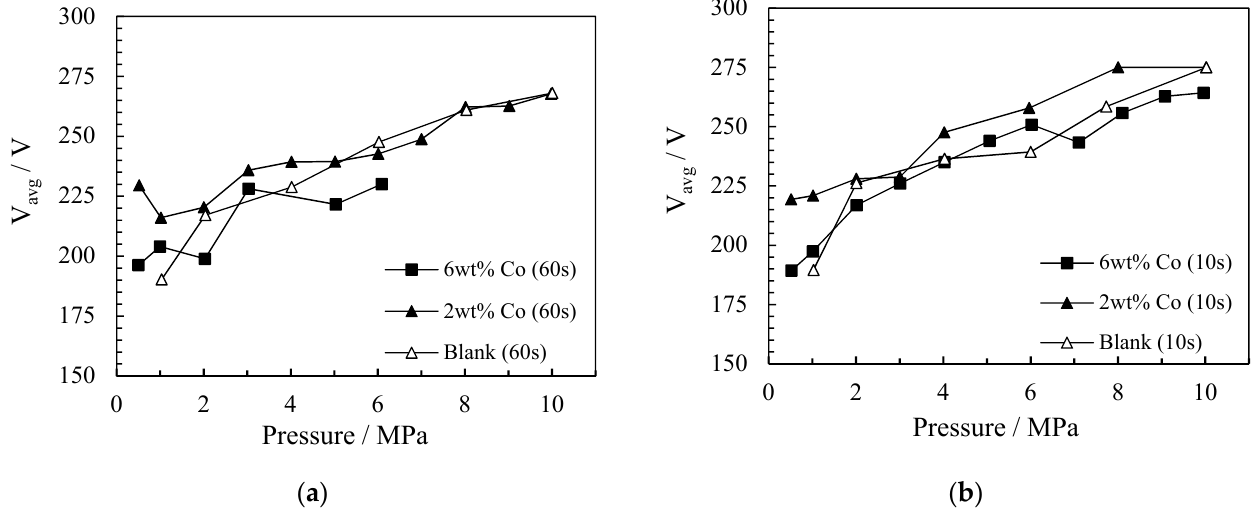
Figure 3. The influence of pressure on average voltage for plasma-catalytic FTS (NTP + Blank, 2 or 6 wt% Co catalyst) at discharge times of ( a ) 60 s and ( b ) 10 s. Legend: (cid:4) —6 wt% Co; (cid:78) —2 wt% Co; ∆ —Blank. Operating conditions: Syngas (H 2 /CO) ratio: 2.2:1; current: 350 mA; inter-electrode gap: 1 mm; wall temperature: 25 ◦ C. Error bars (vertical): Expanded experimental hydrocarbon concentration uncertainty of ±